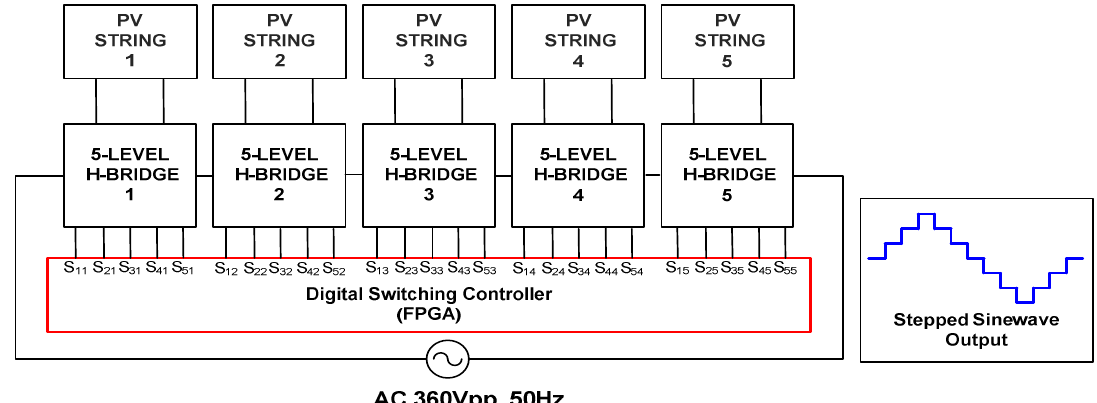
Figure 1. System overview of the 21-level cascaded H-bridge multilevel inverter.